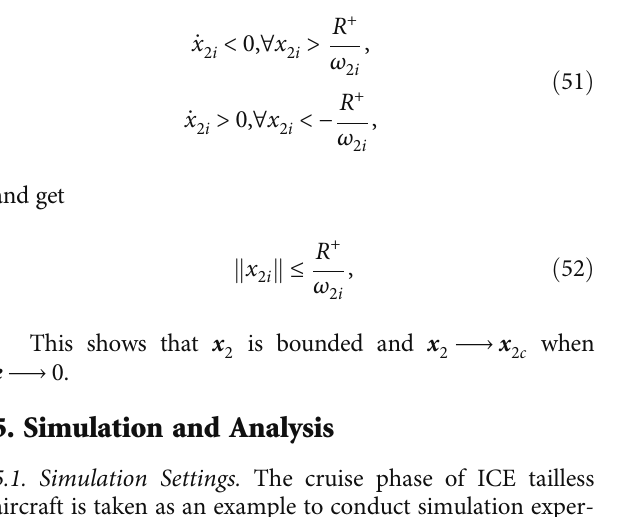
Figure 17: Variation curve of lift coe ffi cient.